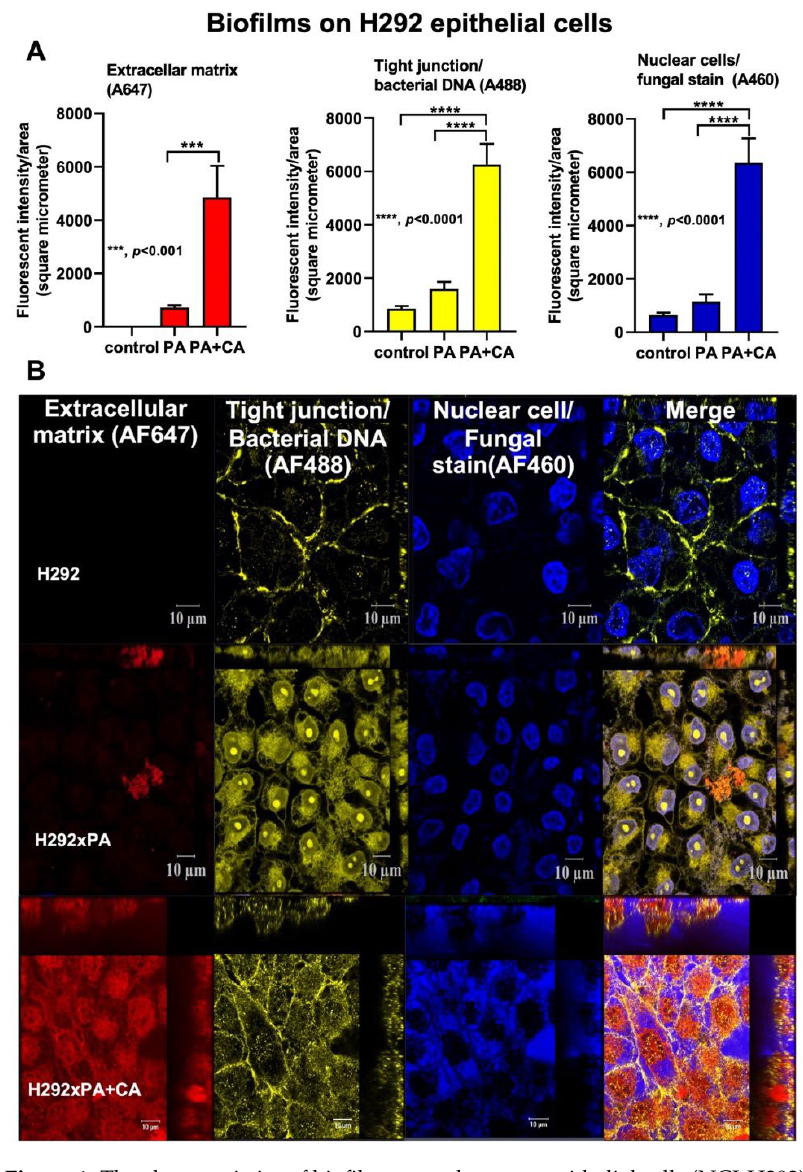
Figure 1. The characteristics of biofilms on pulmonary epithelial cells (NCI-H292) from Pseudomonas alone (PA), Pseudomonas with Candida (PA+CA), and control after staining for extracellular matrix (AF467, red), cell tight junction, bacterial DNA (AF488, yellow), and nuclei of host cells and fungi (AF460, blue) as indicated by fluorescent intensities ( A ), and the representative pictures ( B ) (inde- pendent experiments were performed in triplicate). Despite being the same color, the linear feature of the tight junction and the smaller size of the fungal nuclei compared to the host are used for differentiation (see